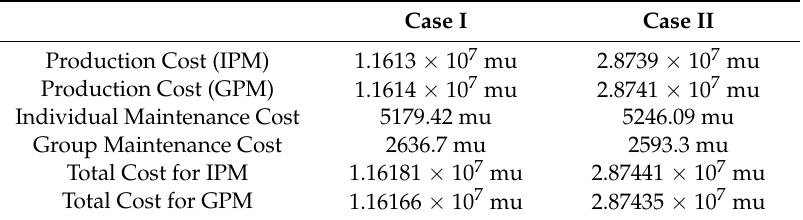
Table 9. Comparison of the performance of the considered approaches for both